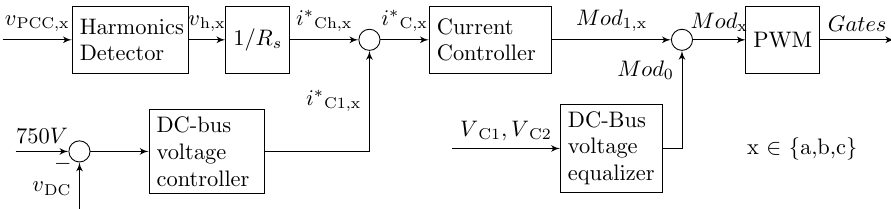
Figure 3. Simplified block diagram of the control system of the Shunt Active Power Filter based on voltage detection (VSAPF). Moreover PWM stands for pulse width